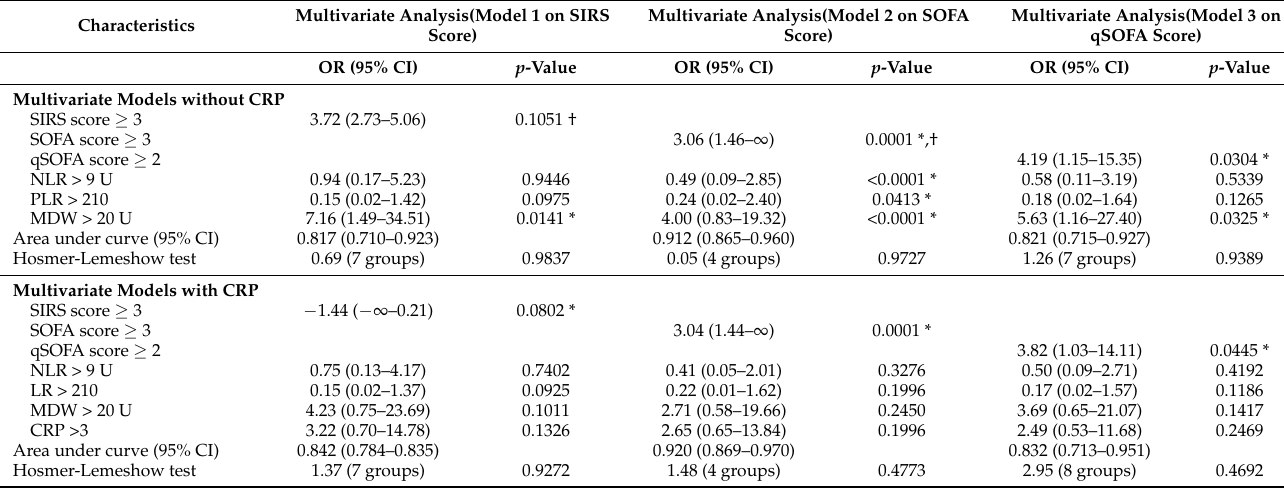
Figure 3. Receiver of operating characteristic (ROC) curves of predicting mortality for models based on SIRS score, SOFA score, and qSOFA score. ( a ) Models without CRP. ( b ) Models with CRP.